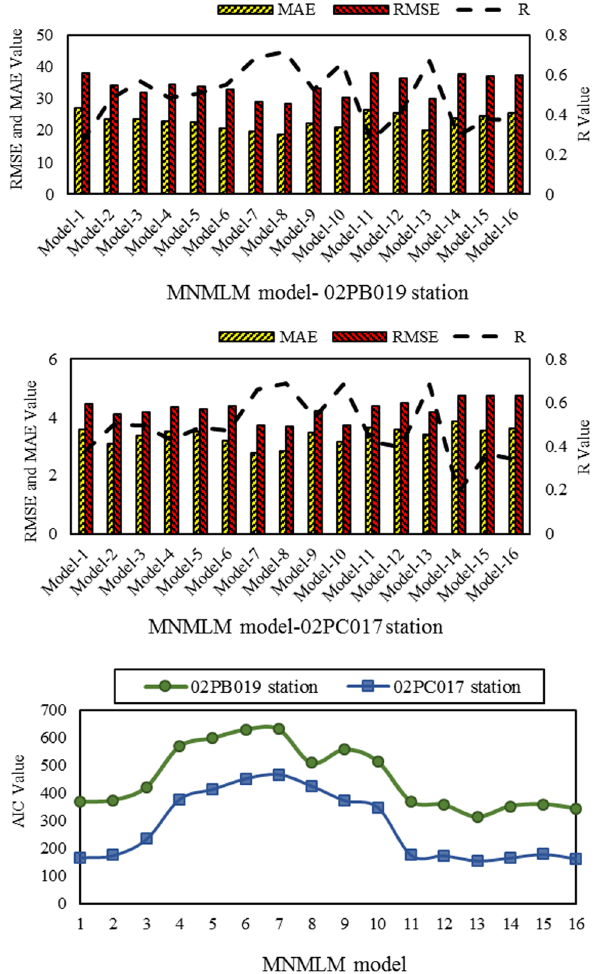
Fig. 6 Results of mathematical metrics including MAE, RMSE, R and AIC for determining the best MNMLM models and for 02PB019 and 02PC017 stations in the study